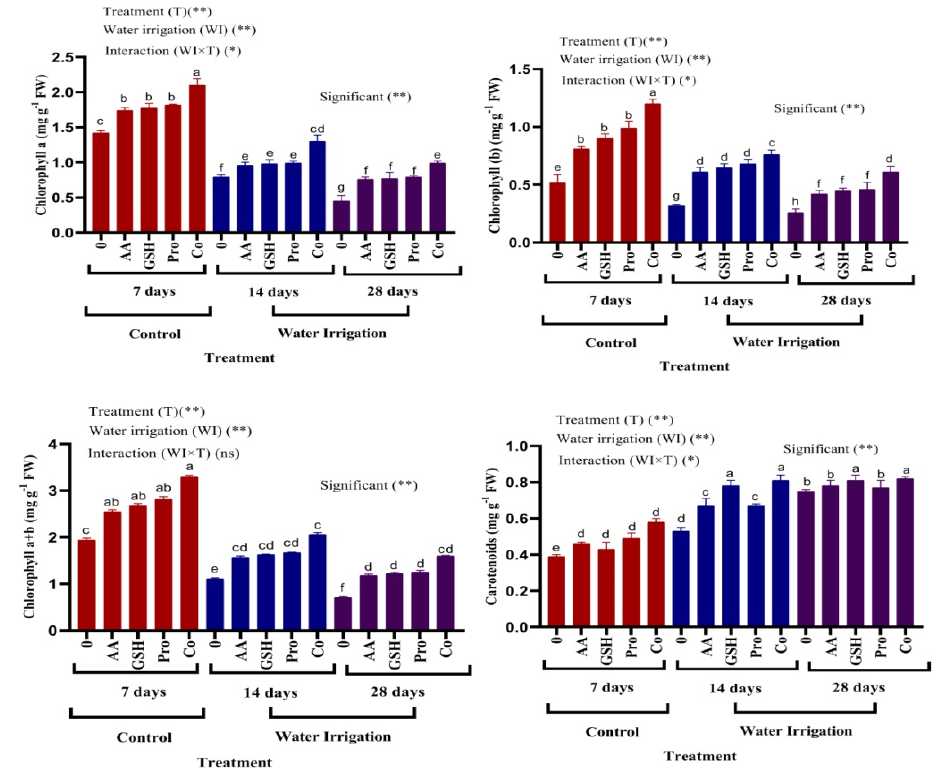
Figure 1. Effect of ascorbic acid, glutathione, and proline on photosynthetic pigments in leaves of chickpea plants under different irrigation intervals. a, b, c, d, e, f, g, h: Different letters next to the mean values in each column indicate significant difference (LSD p ≤ 0.05). *and ** indicate different at p value <0.05, 0.01 probability level respectively, “ns” indicate non-significant.